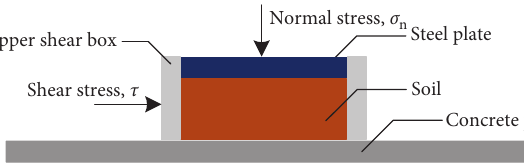
Figure 3: Schematic view of the soil-construct interface.